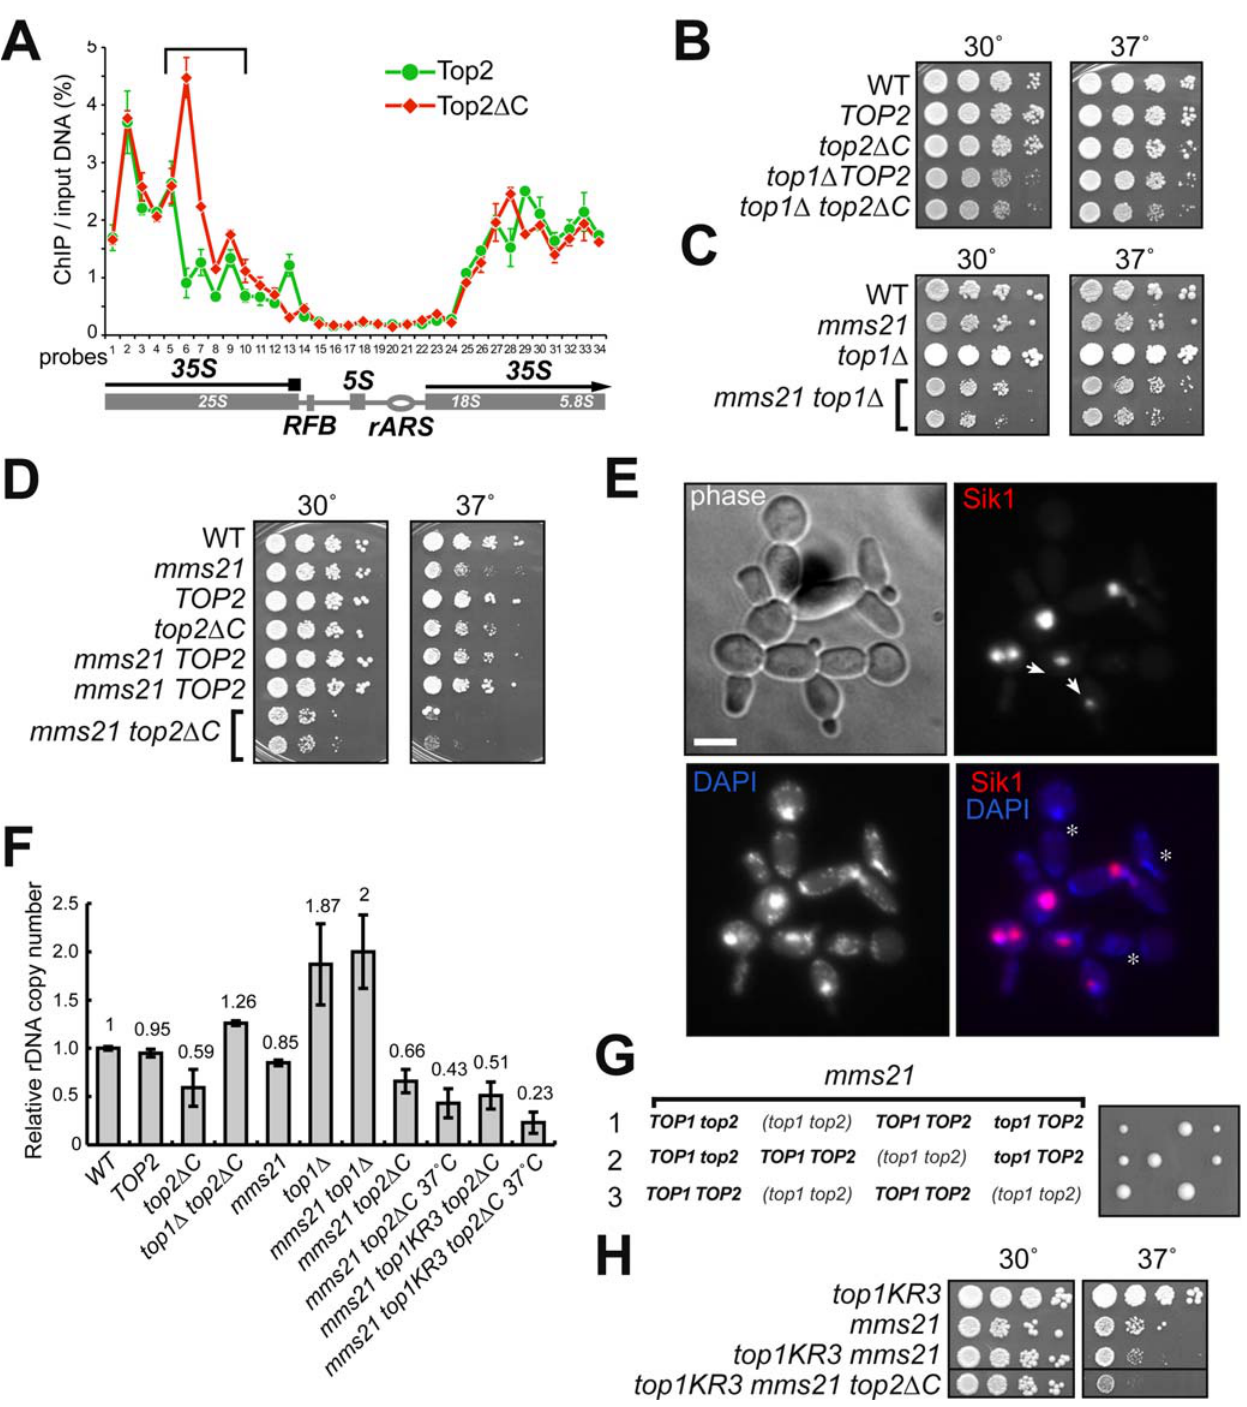
Figure 3. mms21-CH exhibits genetic interactions with top1 and top2 mutations affecting topoisomerase sumoylation. (A) The rDNA binding pattern of Top2p D C differs from that of Top2p. Wild type TOP2 (1033-W303) and top2 D C (1035-W303) strains, both alleles HA-tagged, were analyzed by ChIP/qPCR using the probes covering the whole rDNA repeat as described in [45]. The cells were arrested by nocodazole for 3 hr at 30 u C prior to chromatin cross-linking and extraction. (B) Genetic interactions of top1 D and top2 D C . Wild type strain ( WT , W303-1A) was compared for growth fitness with the following strains: HA-tagged TOP2 (1033-W303), top2 D C (1035-W303), top1 D TOP2 (1aYT624), and top1 D top2 D C (1aYT625). Incubation was for 2 days. (C) Genetic interaction between top1 D and mms21-CH . Experimental conditions were as in (B); wild type, top1 D , mms21-CH (17-YT635) and top1 D mms21-CH (22aYT636) strains were compared. The small colony size was noticeable for the double mutant at both 30 u C and 37 u C. (D) Genetic interaction between top2 D C and mms21-CH . The mms21-CH (17-YT635), wild type (W303), TOP2 (tagged copy, 1033-W303), top2 D C (1035-W303), mms21-CH TOP2 (15cYT636), and mms21-CH top2 D C (16cYT637) strains were incubated for 2 days. The mms21-CH top2 D C double mutant had tight growth arrest at 37 u C (colonies growing at 37 u C were top2 D C excision revertants). (E) Nucleolar defects in the top2 D C mms21-CH mutant. mms21-CH top2 D C (16cYT637) cells expressing a nucleolar marker (Sik1p-mRFP) were shifted to 37 u C and stained with DAPI. More than 95%